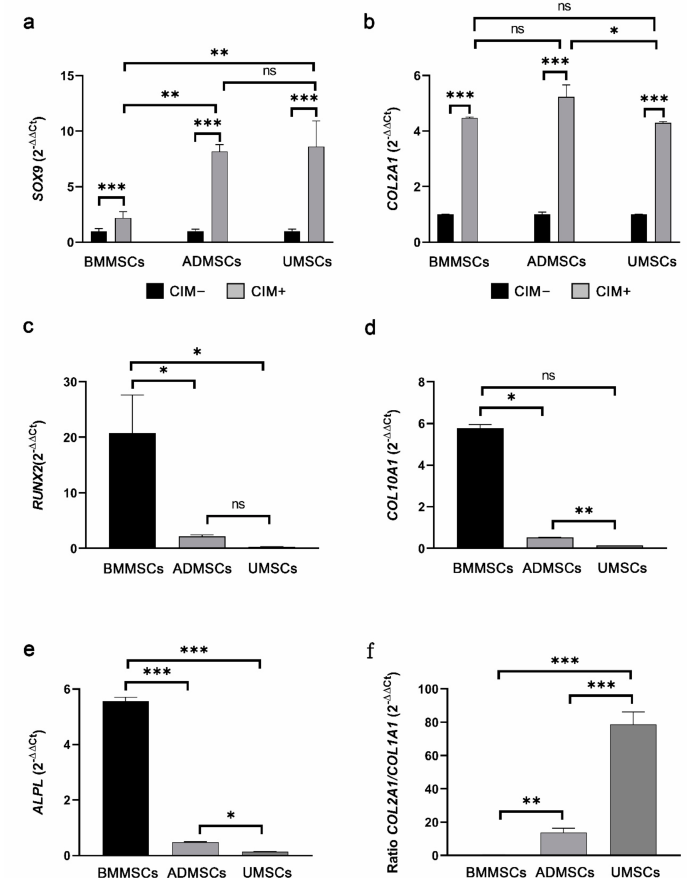
Figure 8. Real-time quantitative polymerase chain reaction analysis of chondrogenic differentiation. Chondrogenic genes ( SOX9 ( a ) and COL2A1 ( b )), hypertrophic differentiation genes ( RUNX2 ( c ), COL10A1 ( d ), and ALPL ( e )), and chondrocyte phenotype (ratio COL2A1 / COL1A1 ( f )) were analyzed, with GAPDH used as the reference gene. Data derived from the treatment of MSCs with chondrogenic differentiation medium CIM+ were normalized to the noninduced (CIM–) groups. ( a , b ) Comparing the noninduced and chondroinduced groups. ( c – f ) Only showed the chondroinduced groups after being normalized to the noninduced groups. A one-way ANOVA with Turkey’s post hoc test was used to examine the differences between experimental groups. Bars indicate the mean ± standard error of the mean. Statistical significance is represented as * p < 0.05, ** p < 0.01, *** p < 0.001, and not significant